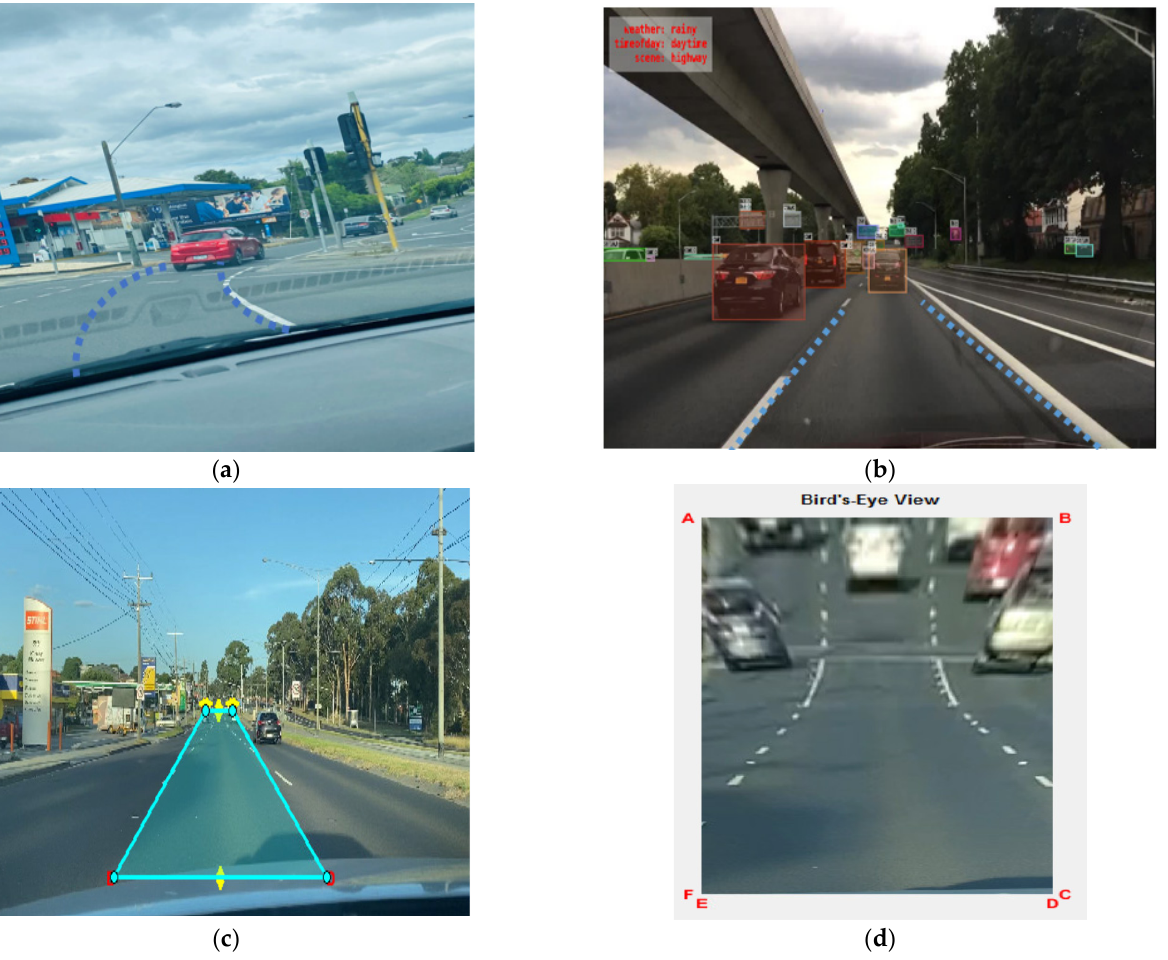
Figure 14. Lane detection and tracking on a structured road: primary data ( a , c ), BD100K secondary data ( b ), and bird’s eye view for close view of the lane ( d ).